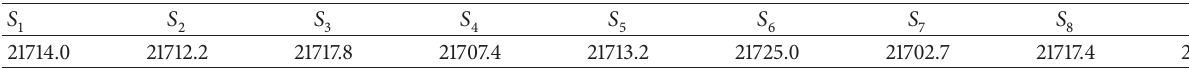
Table 1: Sum invariance illustration for the first 50000 Fibonacci numbers.